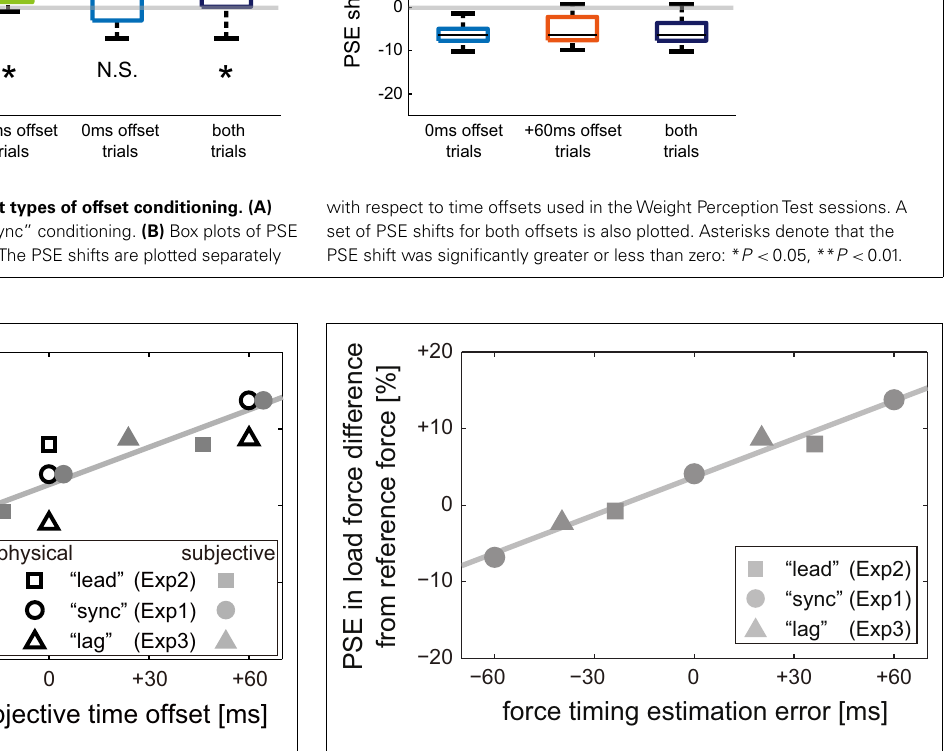
FIGURE 10 | Relationship between perceived weight and estimation error in load force exertion timing. PSEs of group-average psychometric curves for weight judgments in all experiments are plotted with respect to the estimation error in load force exertion timing.The estimation error for α ms offset trials in Experiment β was calculated by subtracting group-average motion initiation timing in Experiment β from the sum of α ms offset and group-average motion initiation timing in